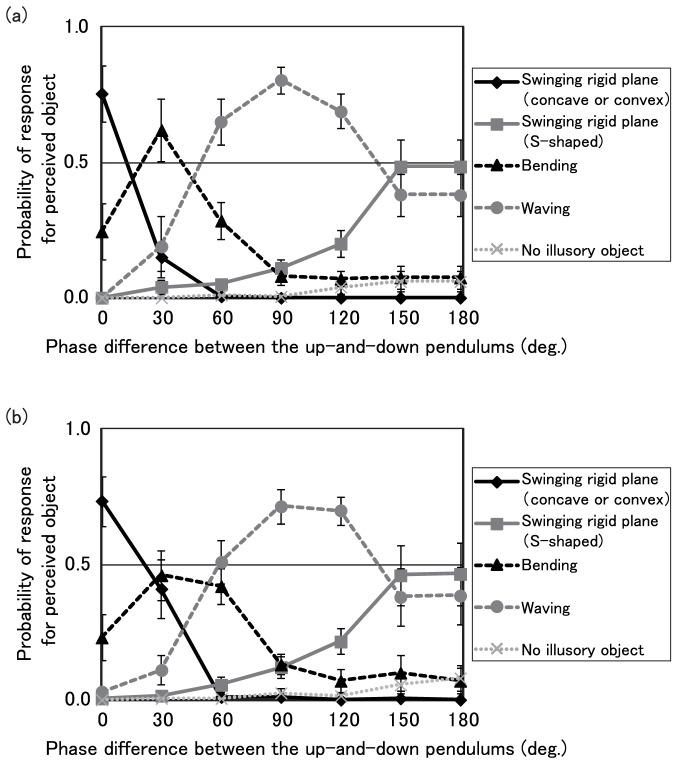
Mean ratings categorized as motion impressions in each phase difference condition under (a) low and (b) high oscillation velocity conditions.The horizontal axis indicates the phase difference (deg.), and the vertical axis indicates the mean probability of rating for perceived object. Error bars indicate standard error (N  = 10).